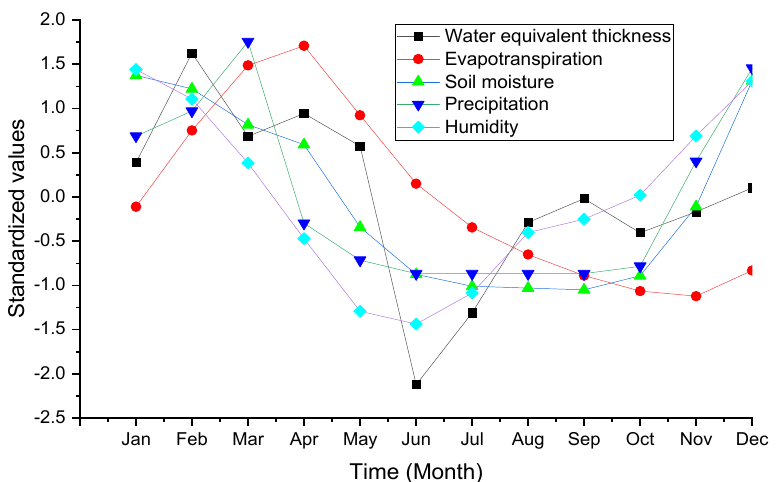
Figure 9. Interannual variation in groundwater, evapotranspiration, soil moisture and rainfall (monthly average data). Sources: groundwater = GRACE-FO; evapotranspiration, and soil moisture = GLDAS; precipitation = QMD.